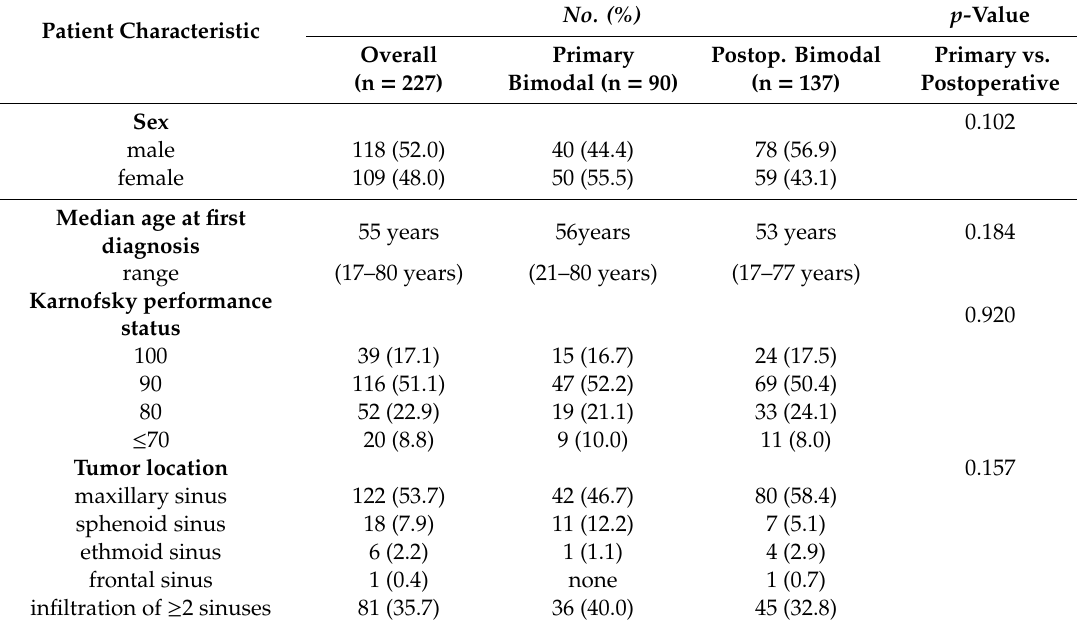
Table 1. Patient, tumor and treatment